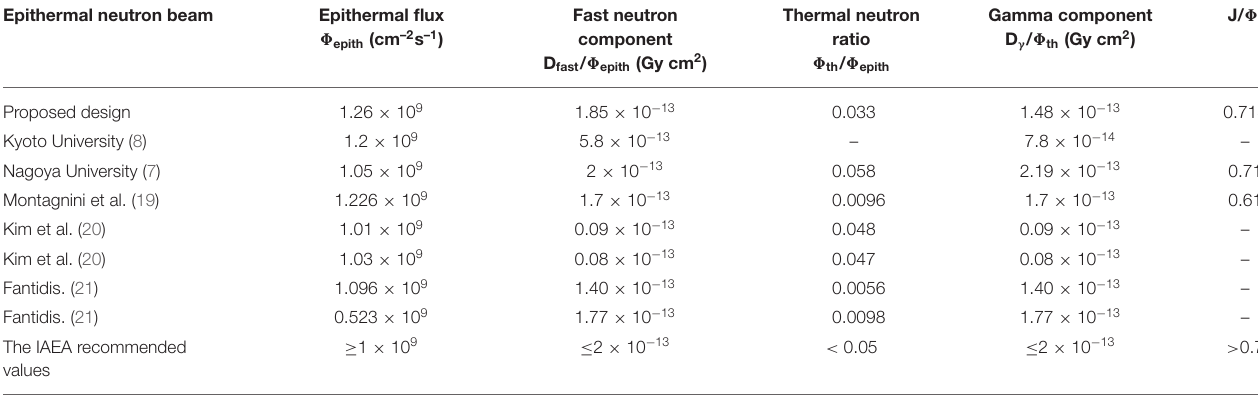
TABLE 3 | Epithermal neutron beam parameters of proposed design and other designs in the